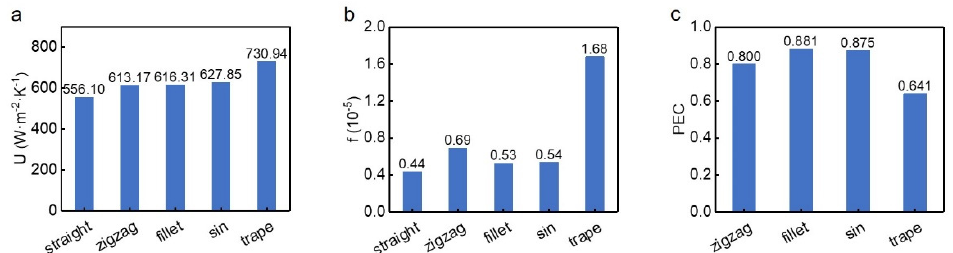
Figure 11. Comprehensive performance of the channels. ( a ) Average surface heat transfer coefficient and ( b ) Fanning friction factor in all the channels. ( c ) Performance Evaluation Criteria value of the wavy channels.